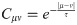
Eigenvalues of C and Fourier spectrum.A: Examples of excitatory input signals xiμ (i ∈ E) with two different covariance matrices C. Top: rbf covariance, τ = 10. Bottom: exponential covariance Cμν=e−|μ−ν|τ, τ = 10. Parameters: x¯E=1, σE = 0.3. B: Theoretical eigenvalue spectrum of C with τ = 10 versus average power spectrum for positive wave numbers across N = 2000 independent processes with P = 1000 time steps.